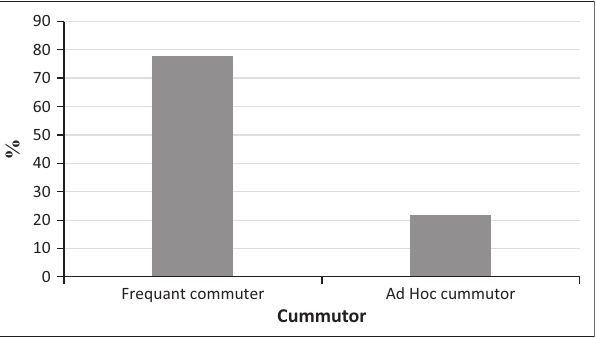
FIGURE 5: Type of